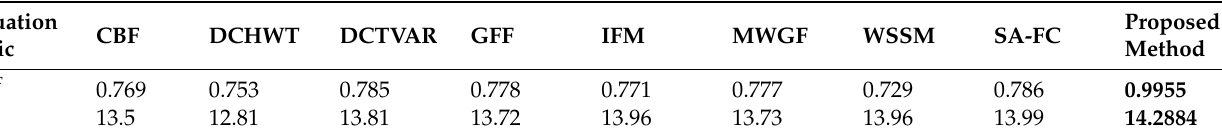
Table 36. The outcomes for the Pepsi image and comparisons with existing techniques in the literature ([30]).